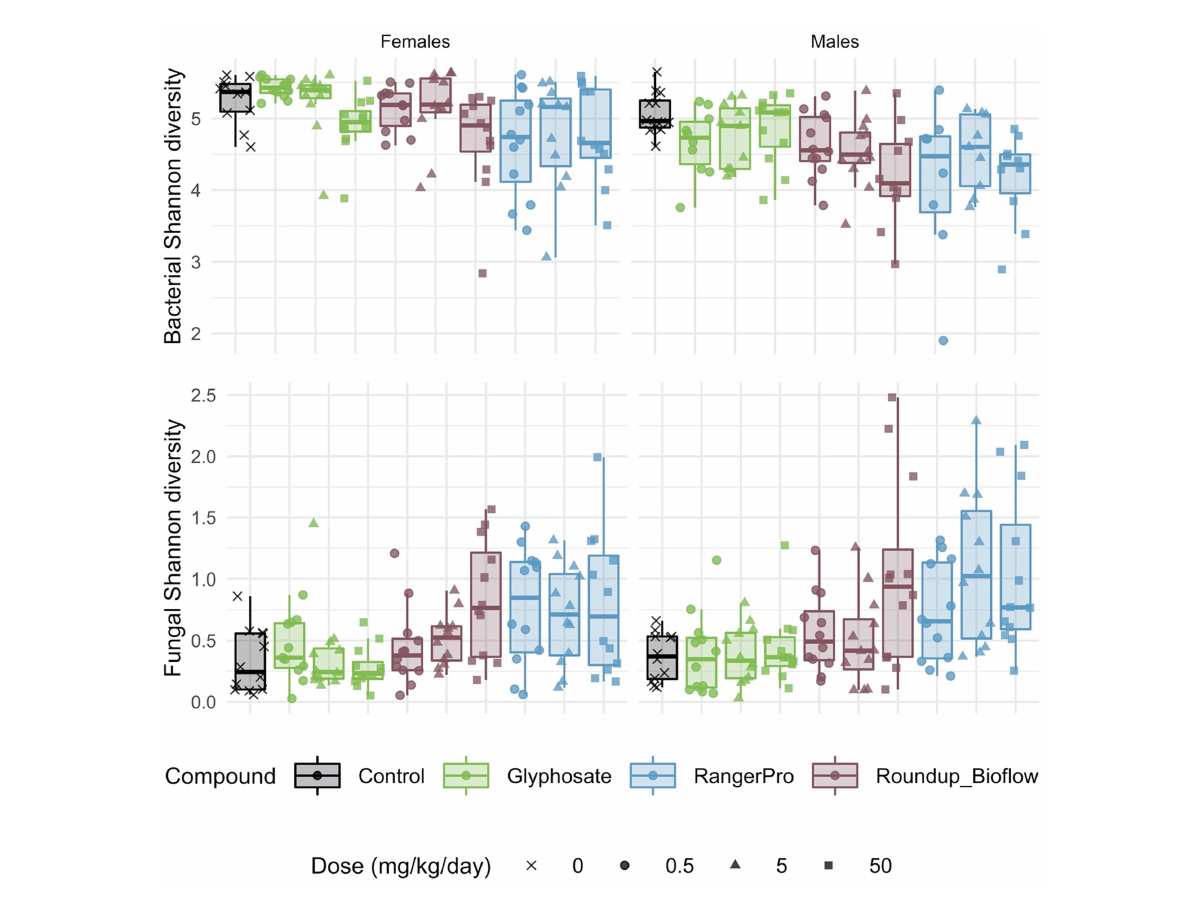
FIGURE 1 Bacterial and fungal diversity is altered in the gut microbiome of rats exposed to either glyphosate or its herbicide formulations Roundup Bioflow and RangerPro. Bacterial and fungal diversity was evaluated by 16S rRNA and ITS2 amplicon sequencing, respectively in male and female SD rats exposed via drinking water to three doses of glyphosate (0.5, 5, 50 mg/kg body weight per day), or to the formulated products Roundup Bioflow and RangerPro at the same glyphosate-equivalent doses. Exposure was initiated prenatally at mid-gestation and continued until 13 weeks post-